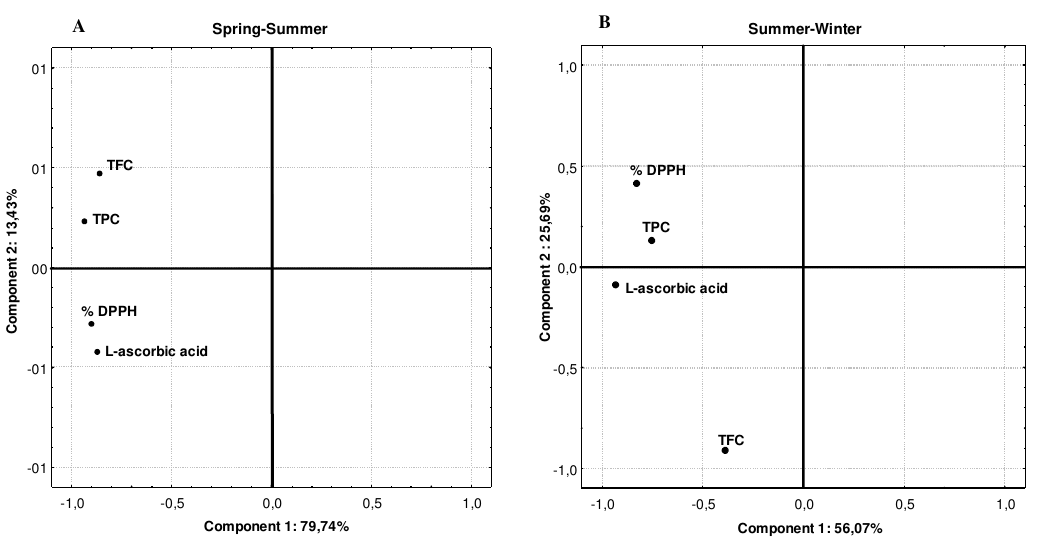
Figure 1. PCA results for AA versus % DPPH: A- across all Brassica samples harvested in Spring-Summer season; B- across all Brassica samples harvested in Summer-Winter season.